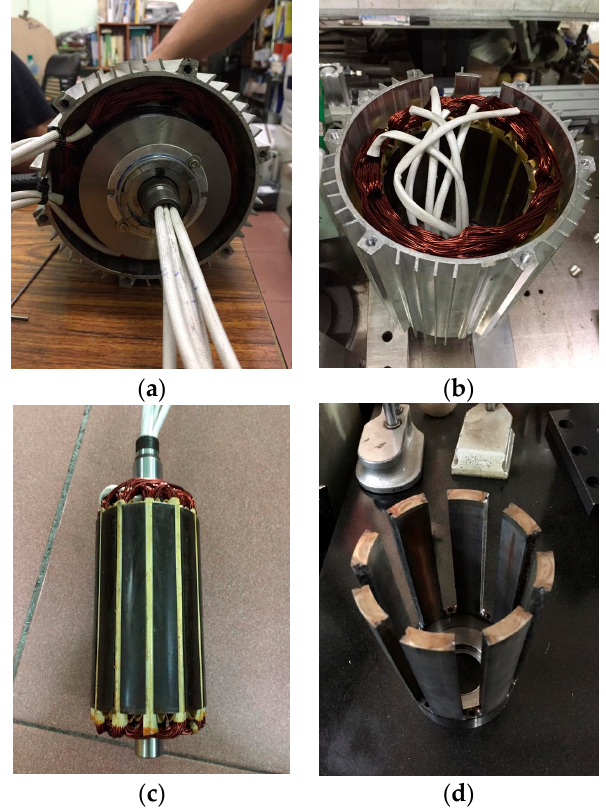
Figure 24. Prototype of Proposed DSSRM: ( a ) whole view; ( b ) outer stator; ( c ) inner stator; and ( d ) rotor.